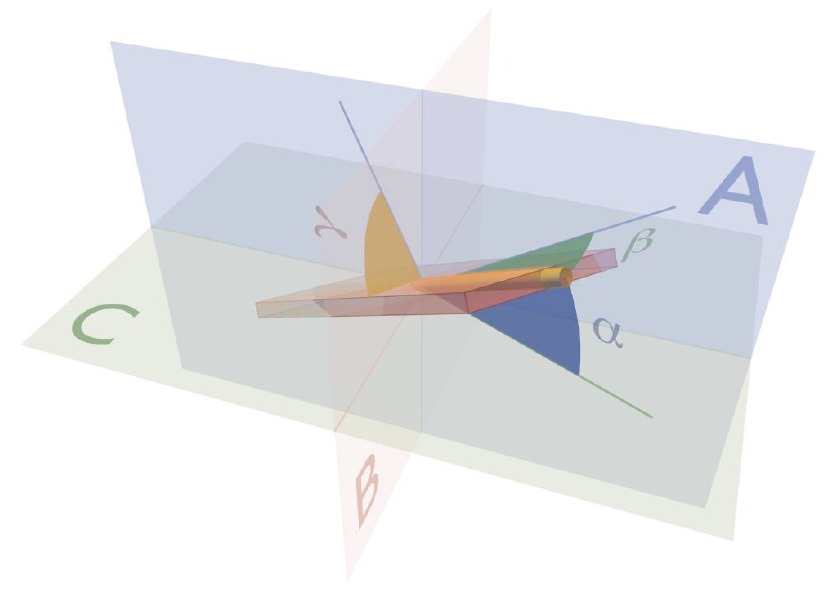
Figure 2. The drawing shows the angles used to define the three-dimensional orientation of the aggregated cardiomyocytes. Plane A is the circumferential-longitudinal plane parallel to the epicardium, while plane B is the radial-longitudinal plane. Plane B is parallel to the left ventricular long axis, and orthogonal to plane A. The third plane, C, is the circumferential-radial plane, which is orthogonal to planes A and B. The helical angle α is the angle between the chain of aggregated cardiomyocytes (yellow rod) and plane C. The transmural angle β is the angle between the chain and plane A. The E3 angle γ is measured as the angle between the aggregate and the circumferential-longitudinal plane. The unit of aggregated cardiomyocytes, depicted as a flat box, is a gross oversimplification of the true three-dimensional arrangement.